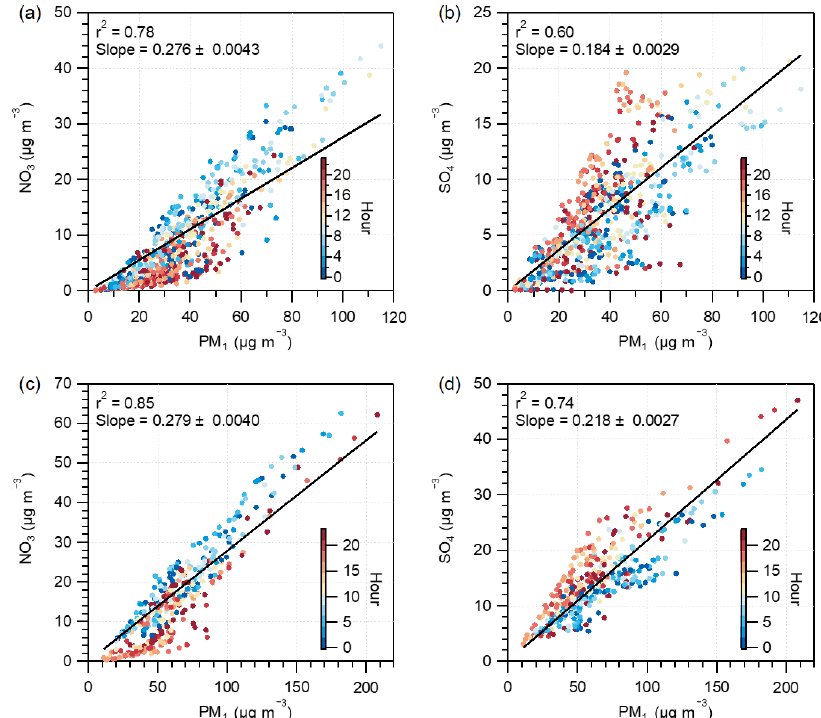
Figure 4. Scatter plots of nitrate vs. PM 1 concentration and sulfate vs. PM 1 concentration, colored by the hour of the day, in (a–b) Beijing and (c–d) Xinxiang.